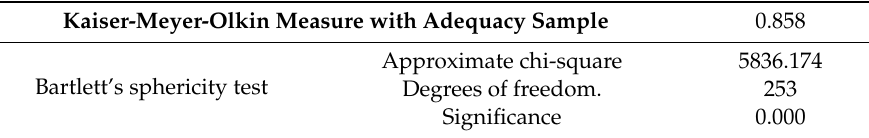
Table 5. The Kaiser-Meyer-Olkin (KMO) and Bartlett’s tests.